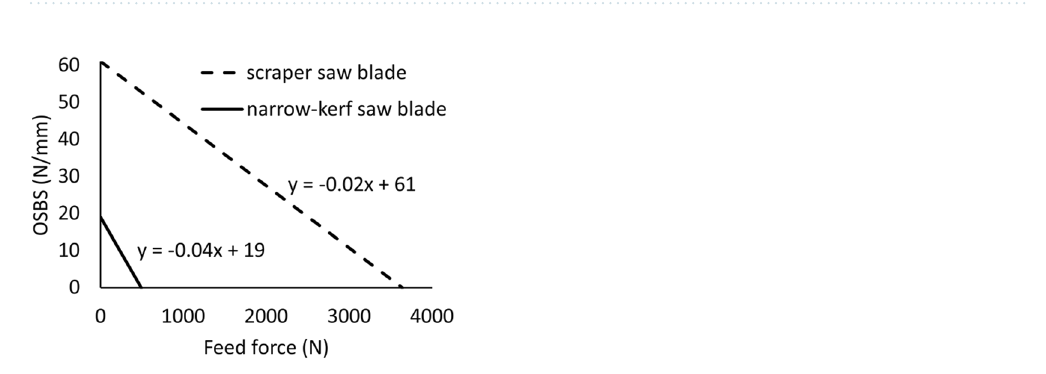
Figure 7. The elastic characteristics of the narrow-kerf and scraper saw blades. Note: each saw blade was tensioned with the force F N = 9450 N.